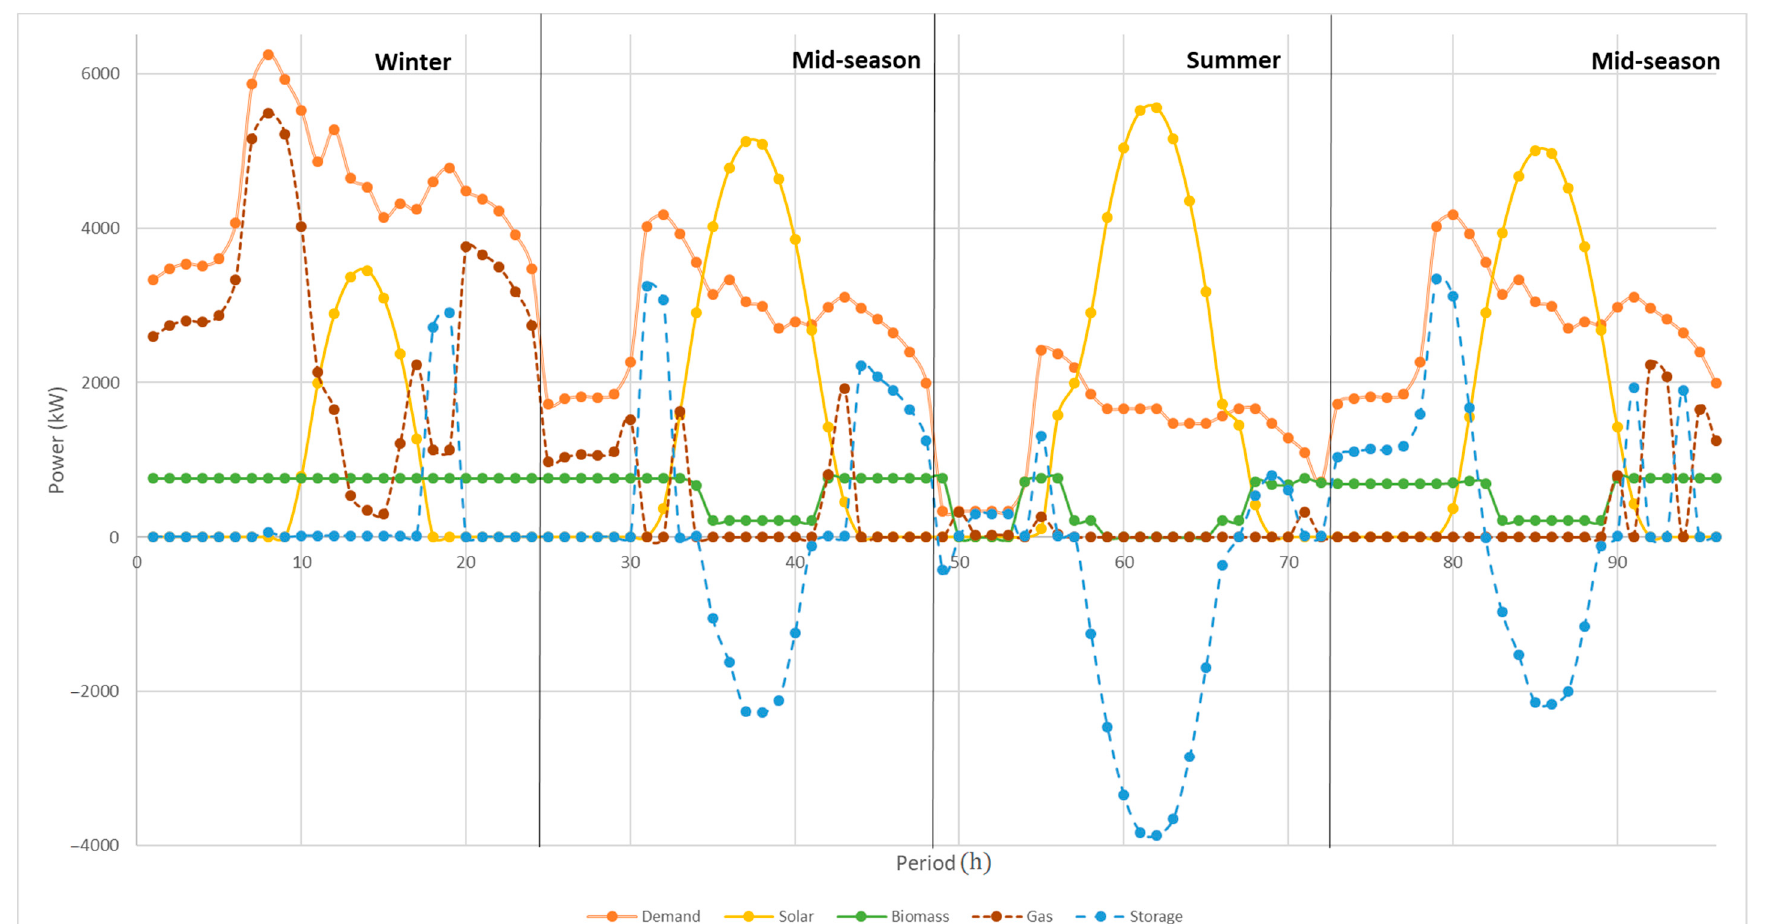
Figure 15. Optimal power operation for storage connected after solar field (connection 1).